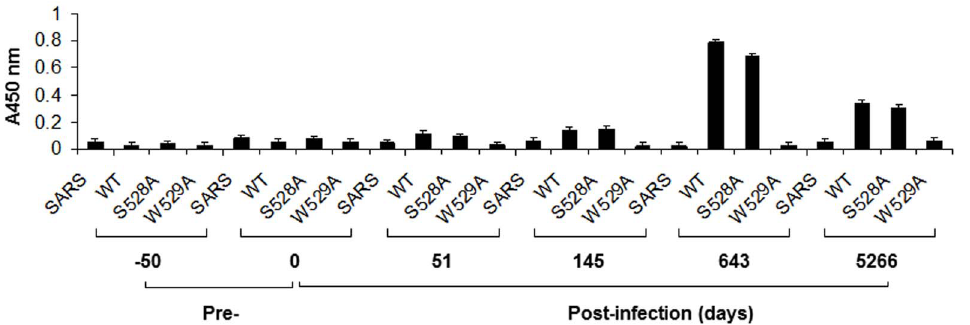
Figure 7. Time course of epitope-specific antibody production in Patient H. Biotin-linked peptides containing the 1H8 binding site and the specific mutation of the binding site were incubated with streptavidin-coated 96-well plates at 200 ng/well. The plasma samples obtained from Patient H were diluted 1:800 for the ELISA. An unrelated peptide was used as a negative control for the assay. The data were obtained from at least three independent experiments. The x-axis indicates the peptide used in the ELISA and the time when the sample was collected. The y-axis indicates the absorbance at 450 nm, representing the binding activity of the ‘‘1H8-like’’ antibodies in the samples from Patient H.